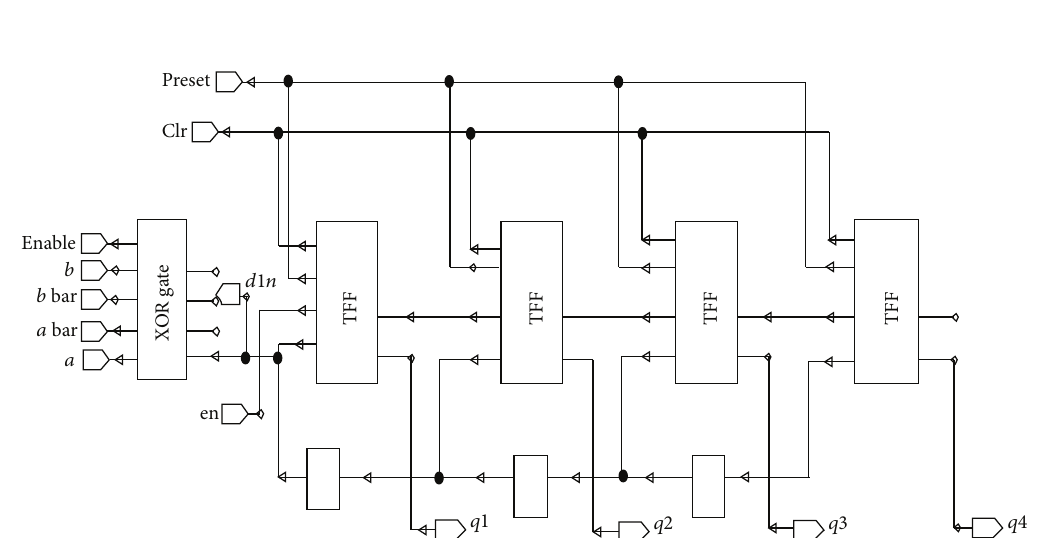
Figure 5: Hardware realization of branch metric computation